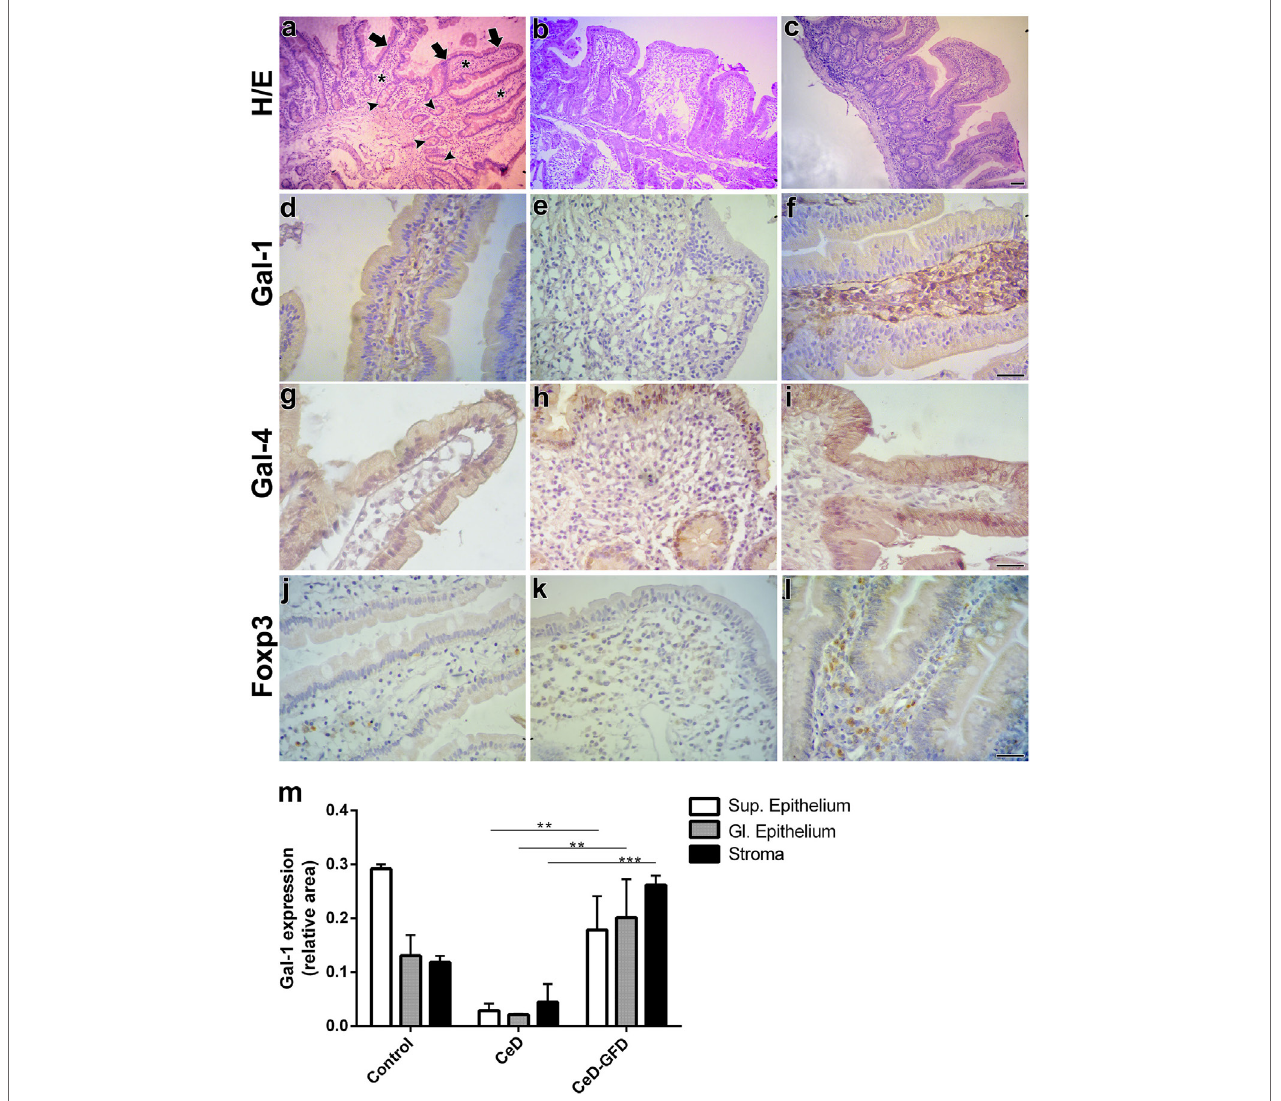
FiGUre 2 | Expression of galectin-1 (Gal-1), Gal-4, and Foxp3 in response to gluten-free diet (GFD) in duodenal biopsies from celiac disease (CeD) patients. Representative micrographs of control subjects, untreated CeD patients and CeD patients subjected to gluten withdrawal (CeD-GFD patients) are